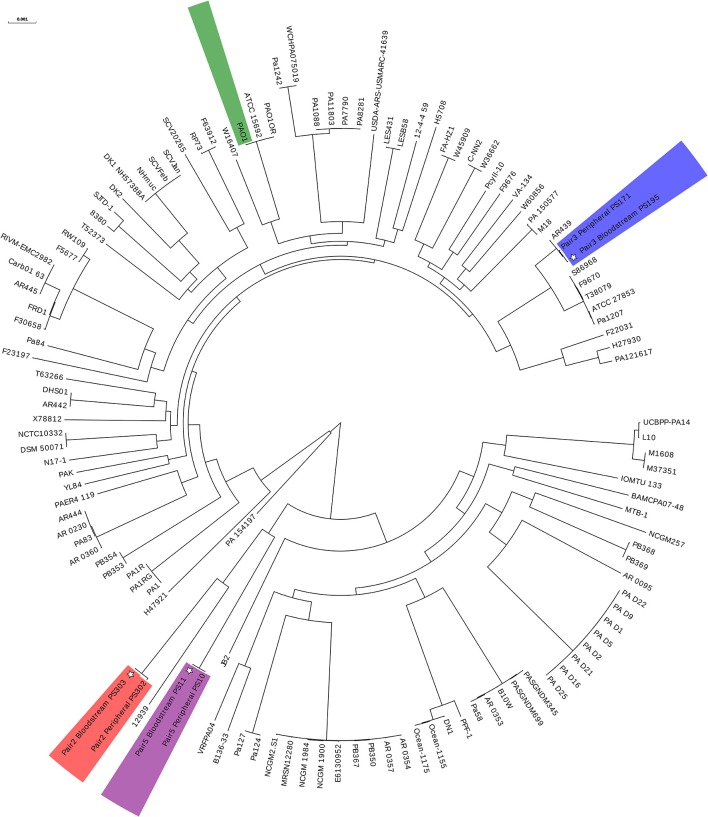
Circular phylogenetic tree showing relatedness of 3 paired bloodstream and peripheral isolates. Whole genome sequencing and phylogenetic analysis performed on 3 out of 7 paired isolates. See Table 1 for further details on paired isolates. Tree constructed using core genome SNPs of 118 P. aeruginosa strains. Paired isolates are shown in color with individual laboratory identifiers (PSXXX) listed beside isolate label. PAO1 is shown in green. *bloodstream isolates.